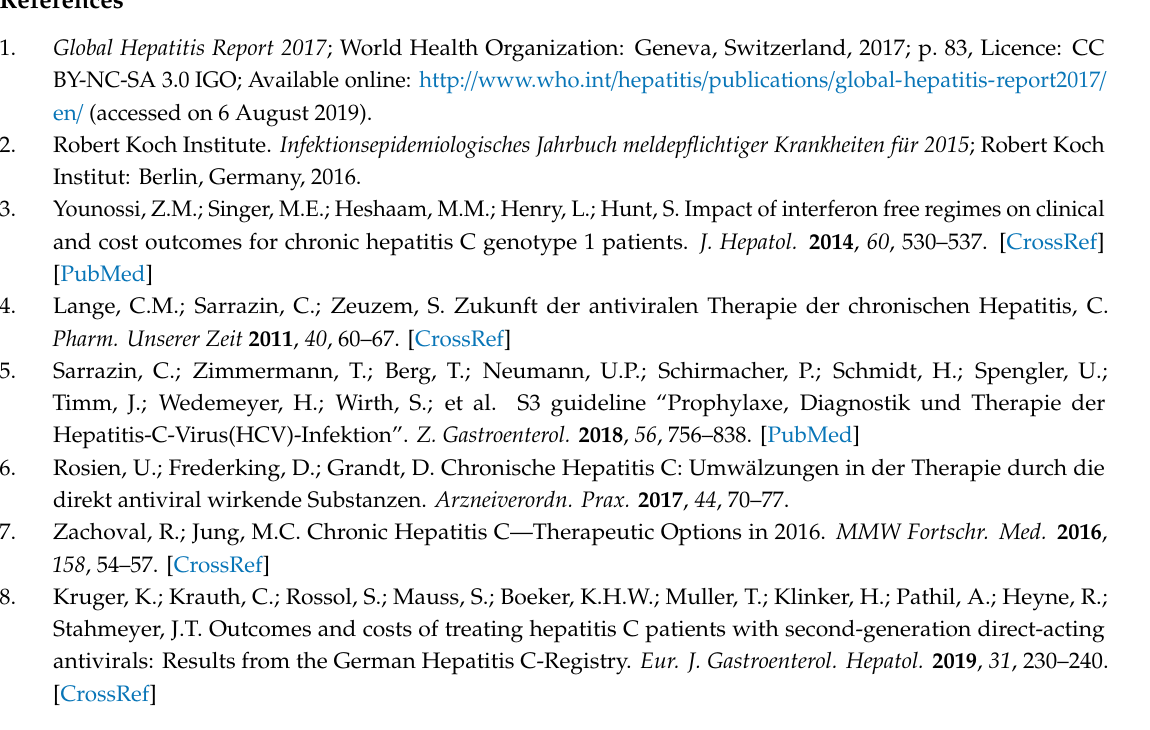
Table S1: Consolidated Health Economic Evaluation Reporting Standards (CHEERS) checklist, Figure S1: DAA result calculation, Figure S2: DAA therapy cost calculation, Figure S3: Triple therapy result calculation, Figure S4: Triple therapy cost